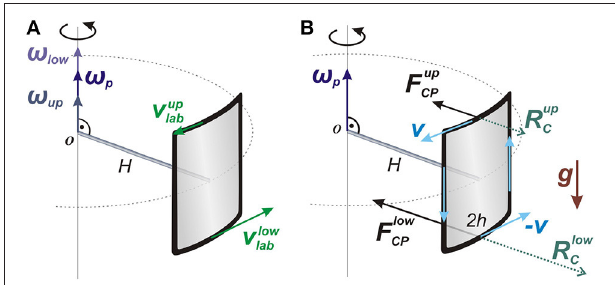
FIGURE 3 | (color online) The bent square wheel model, viewed from the laboratory (inertial) reference frame (see section 2.3). (A) The axis of length H precesses in the horizontal plane with angular frequency ω p . The velocities of the chain/fluid mass elements, measured from the laboratory frame (green arrows), have lower magnitude in the upper segment (where the speed of the chain/fluid elements subtracts from that of the surrounding support), and higher magnitude in the lower segment (where these speeds add up). (B) Constraint forces act on the chain/fluid elements (black continuous lines) while reactive forces act on the support (green dotted lines). Note the lower magnitude of the forces acting in the upper segment. Blue arrows represent the chain/fluid velocities measured from the precessing frame, which are identical around the support. Notation of forces (see section 2.2): F CP - centripetal, R C - reactive central. The pair of forces, R C , act on the support and generate the “lifting" torque counterbalancing the gravitational